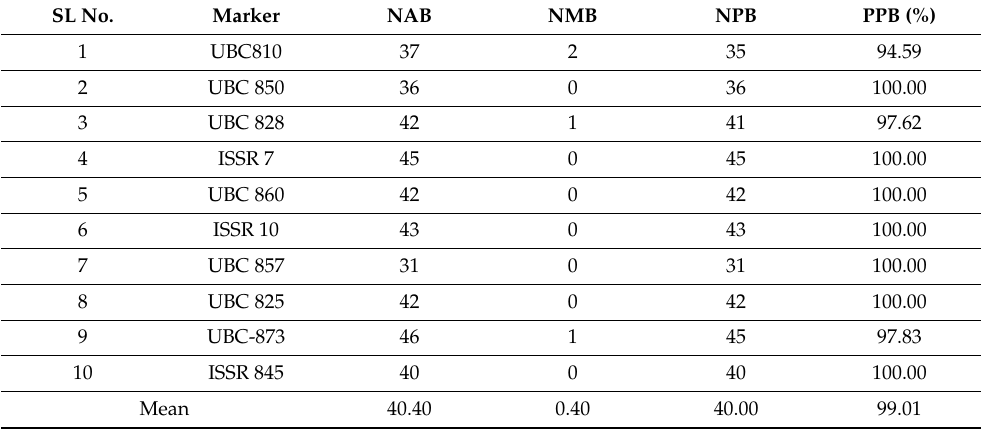
Figure 7. Representative DNA fingerprinting profiles of C. falcatum isolates generated by different ISSR molecular markers ( a ) UBC 810; ( b ) ISSR 10; ( c ) UBC 860 and ( d ) UBC 873. Table 5. Polymorphism of C. falcatum isolates from different locations in Bangladesh generated by 10 ISSR markers.